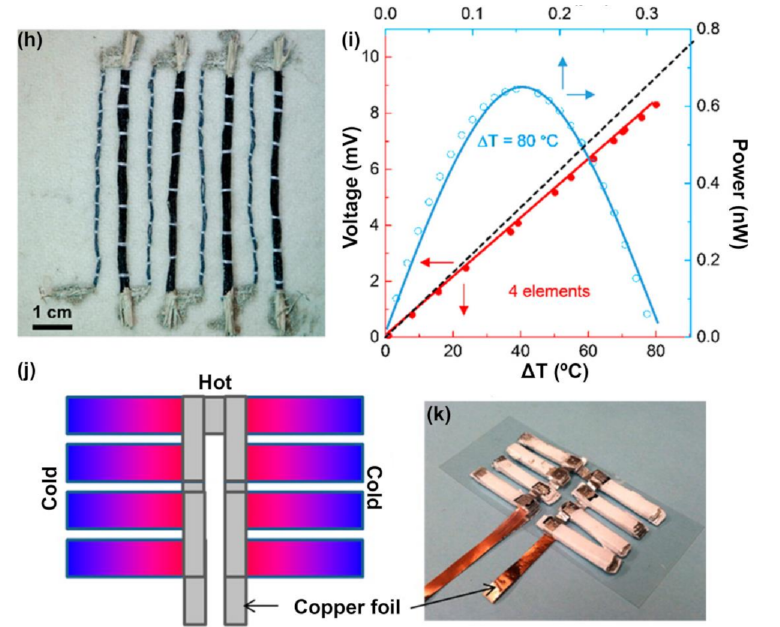
Figure 8. CNT-based TE devices integrated into textiles. ( a ) Polyester fabric that is coated with SWCNT/PANI composite in ( b ) to create a TE generator [77]. Reproduced with permissions [77]. Copyright 2016, The Royal Society of Chemistry. ( c – g ) Warp-knitted spacer fabric as TE textile (TET) with ( c ) showing the cross-section of the TET (scale bar = 2 mm), ( d ) 8 cm × 9.3 cm TET fabric (scale bar = 2 cm), ( e ) bending, ( f ) twisting, ( g ) compressing the TET fabric [6]. Reproduced with permissions [6]. Copyright 2020, The Royal Society of Chemistry. ( h ) Textile TE device with 4 p-n pairs, composed of n-type coated PET yarns (11 yarns/leg) and p-type dyed silk yarns (2 yarns/leg) with its output voltage and power generated as a function of temperature difference shown in ( i ) [7]. Reproduced with permissions [7]. Copyright 2018, American Chemical Society. ( j ) Design of a CNT- based TE module with ( k ) showing the device with 72 TE pairs. Reproduced with permissions [78]. Reproduced with permissions [78]. Copyright 2014, American Chemical